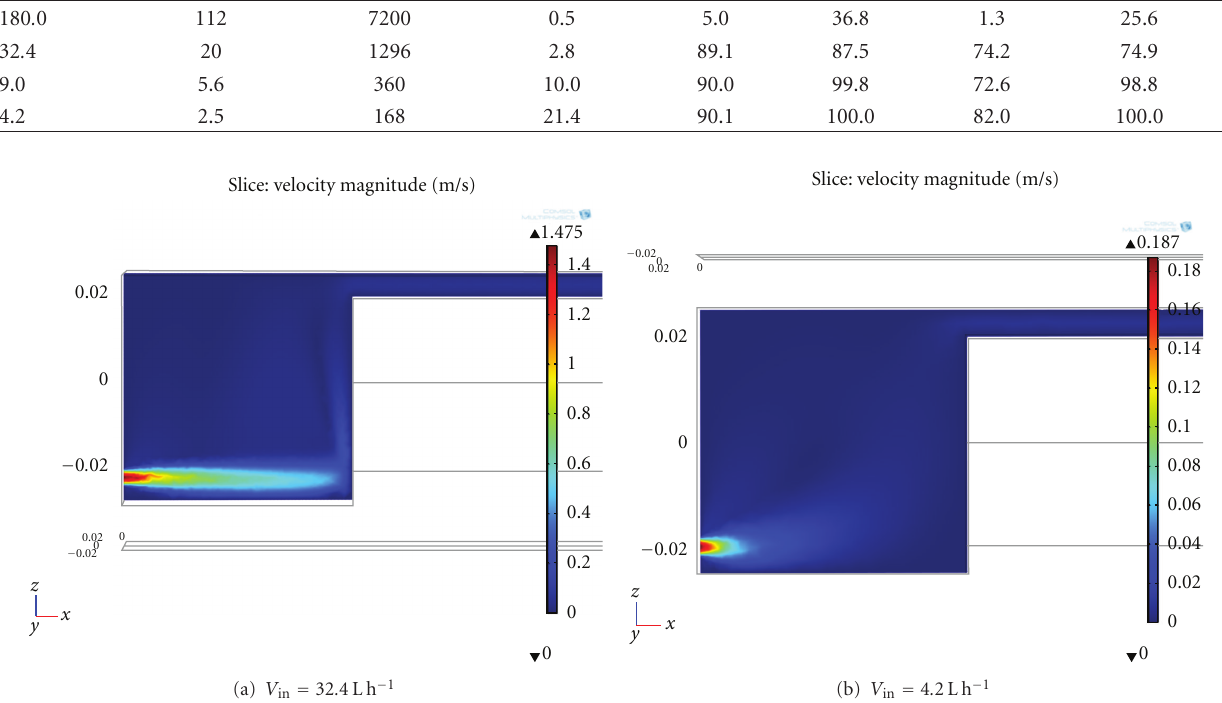
Figure 4: xy cross-sections of simulated fluid dynamic under steady-state conditions of the reactor used for the photocatalytic test (flowing conditions). (a) V in = 32.4Lh − 1 , (b) V in = 4.2 Lh − 1 . The cross-section follows the longitudinal symmetry and is focused on the inlet gas chamber and a portion of the channel containing the photoactive